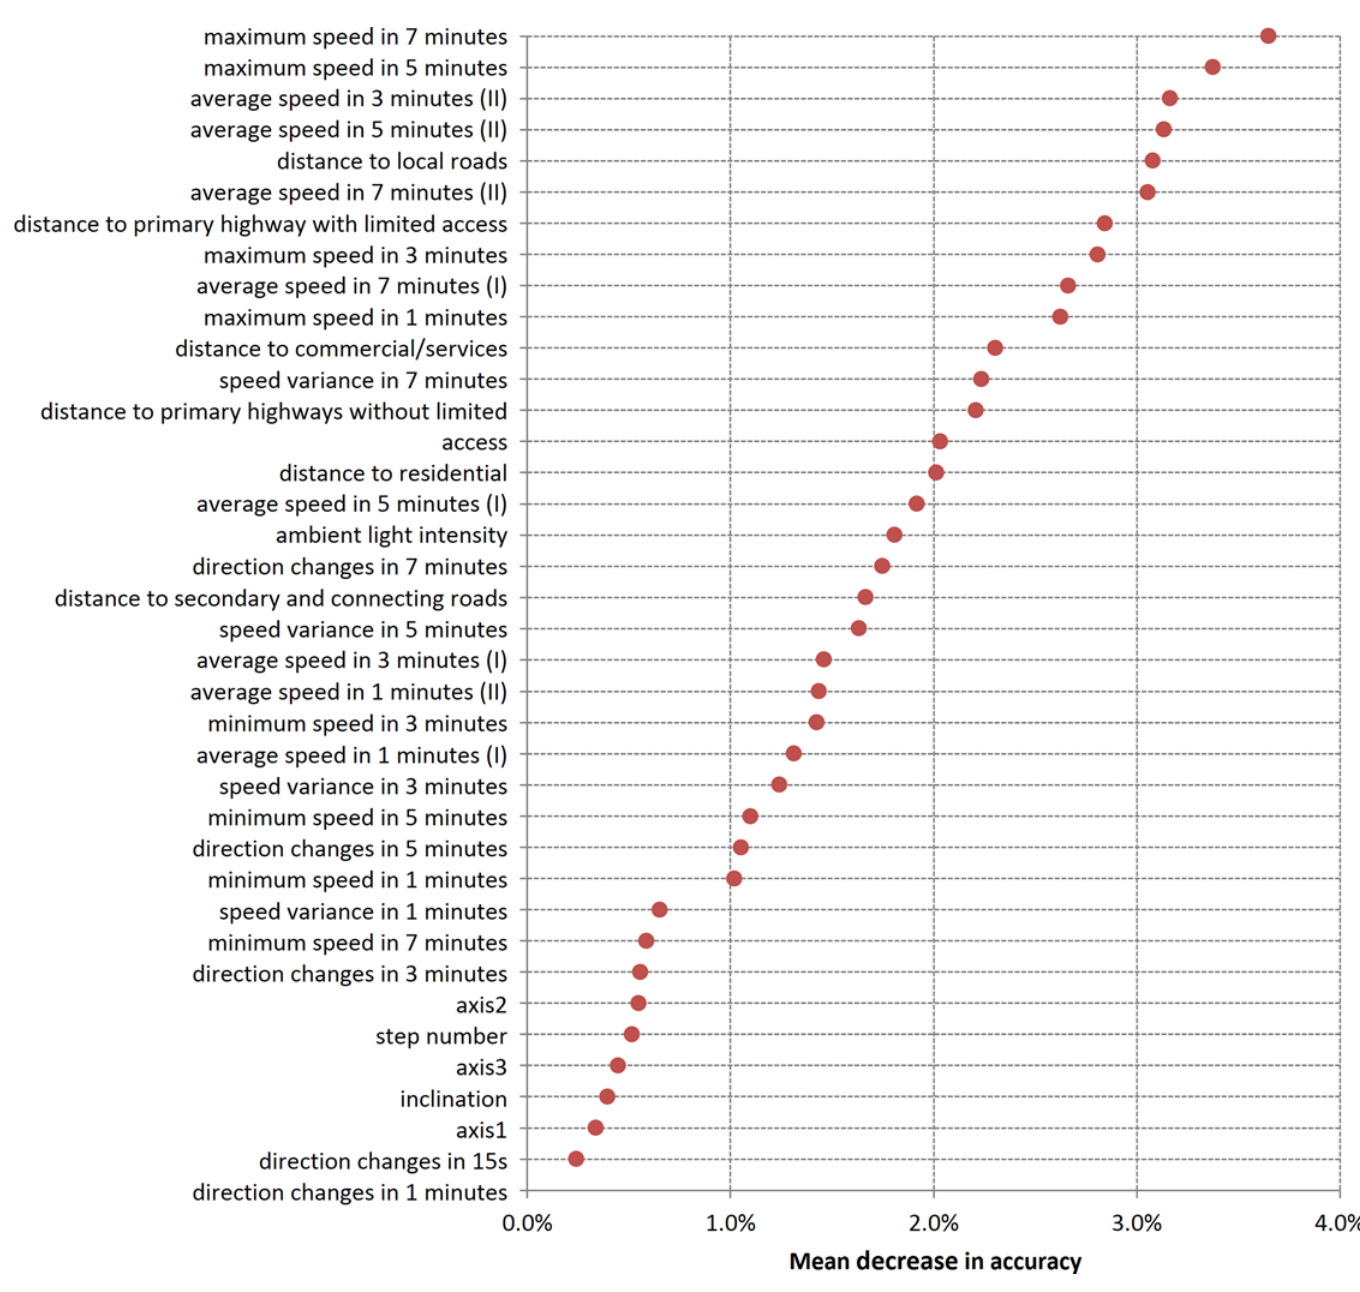
Fig 3. Mean decrease in accuracy for candidate